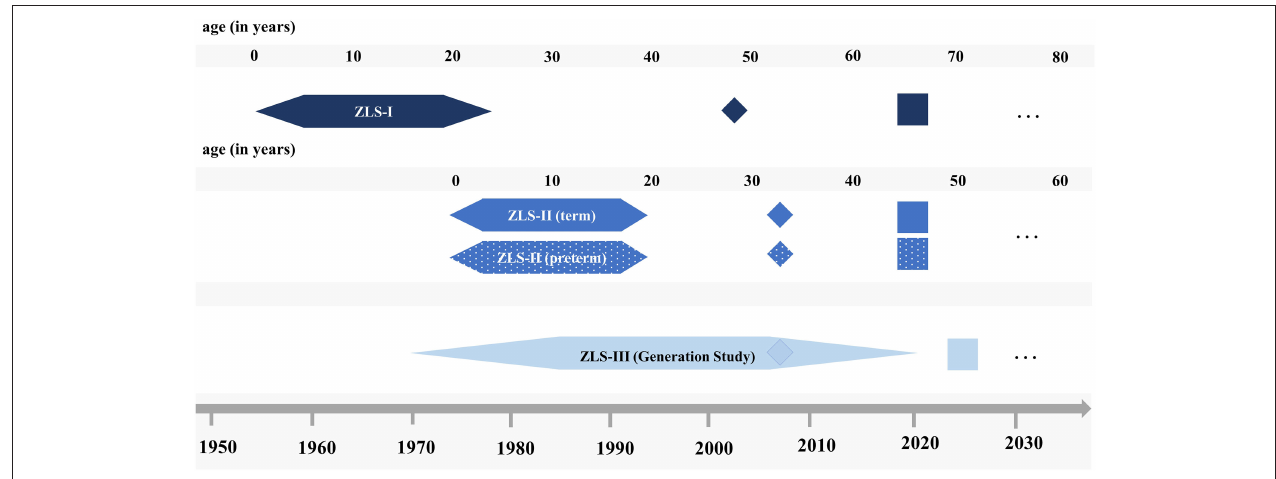
FIGURE 2 | Schematic illustration of the set-up of the three ZLS cohorts. Hexagons indicate ZLS-Childhood assessments, diamonds indicate sub-studies on motor abilities and rectangles indicate the first assessment wave of ZLS-Adulthood. Dots refer to potential future assessments (please refer to text for details).